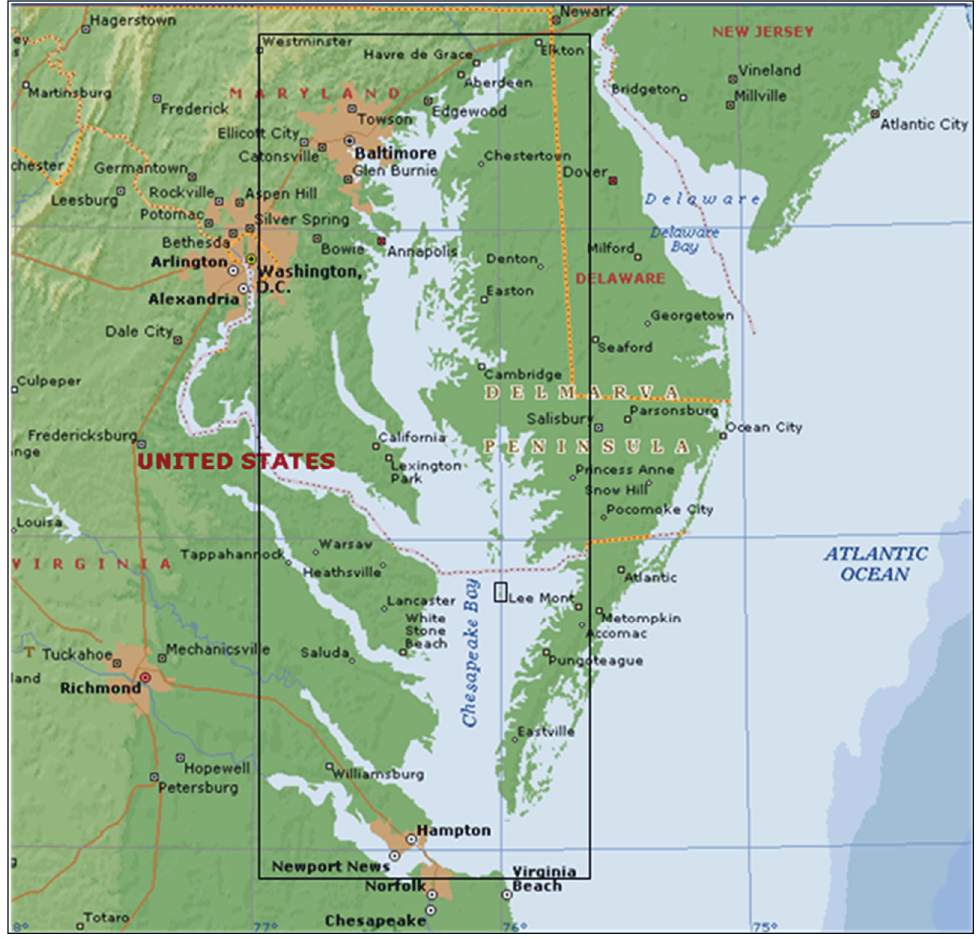
Figure 1. Location of Tangier Island (small rectangular box) in Chesapeake Bay (large